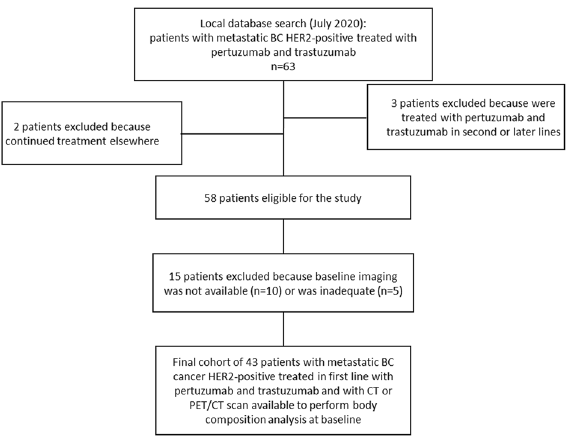
Figure 3. Flow chart of patient